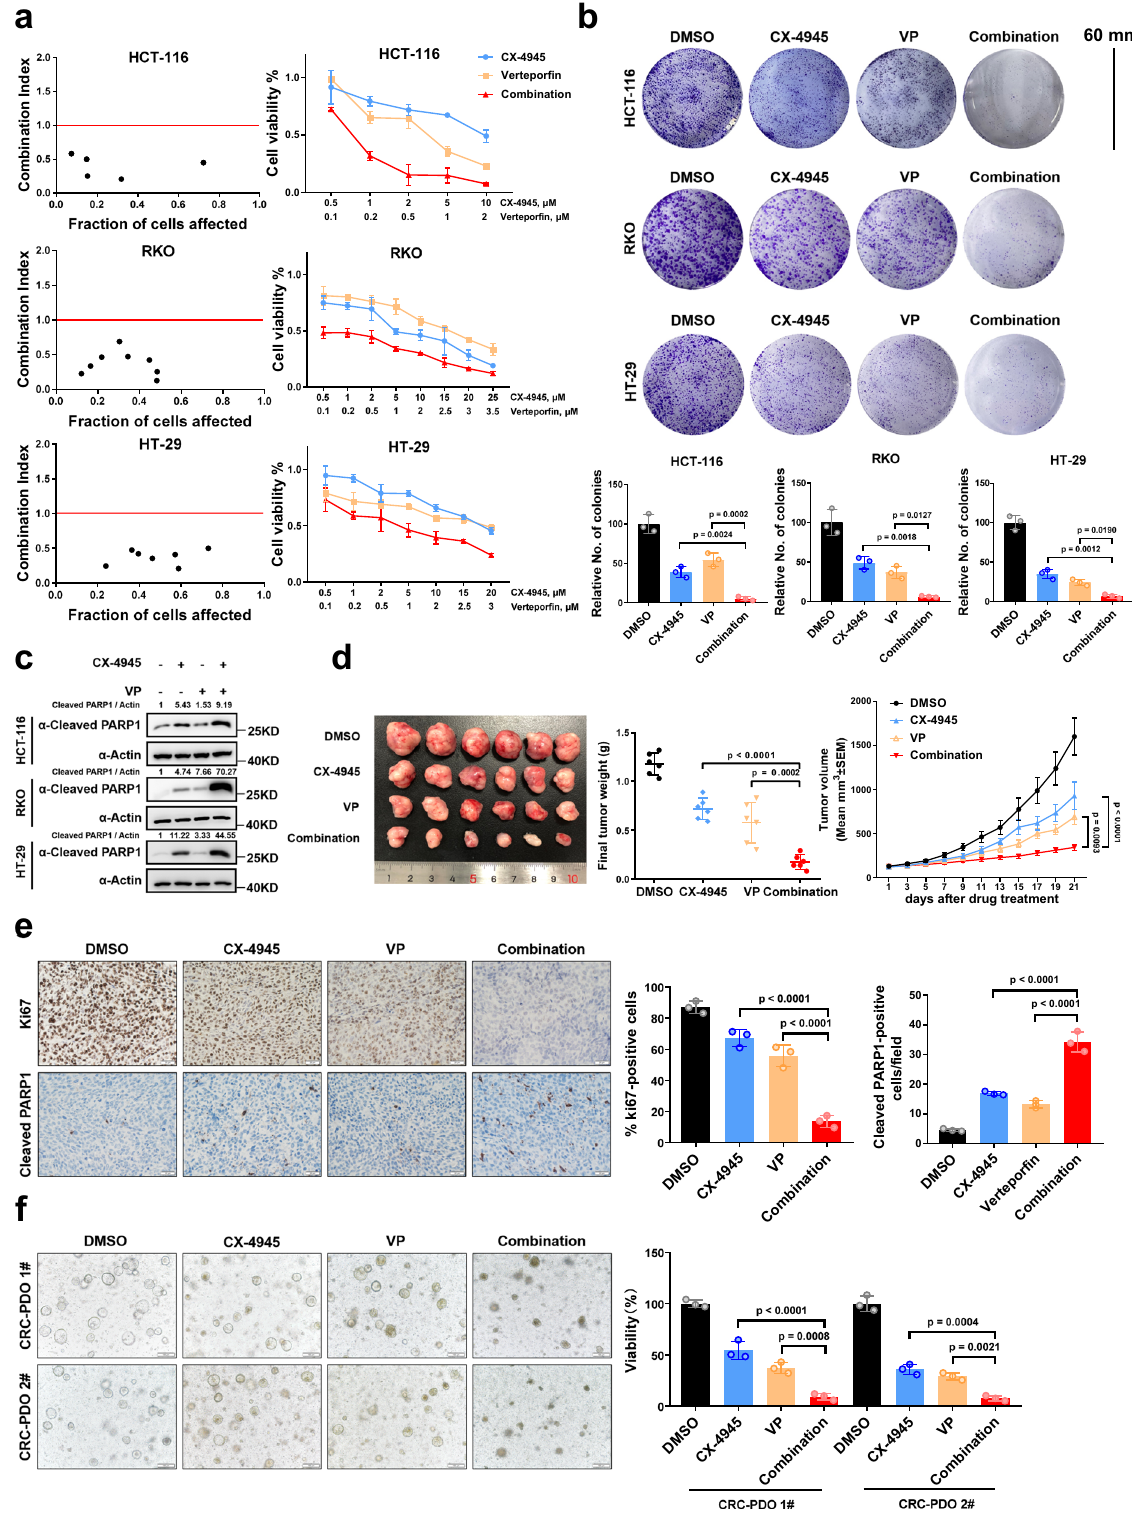
protocol by using the heat-induced epitope retrieval method. The semiquantitative analysis was performed as followed: The staining intensity was scored as 0 (lack of staining), 1 (weak staining), 2 (mod- erate staining), or 3 (strong staining), and the percentage of staining was scored as 1 (<25%), 2 (25 – 50%), 3 (50 – 75%), or 4 (>75%). IHC staining was assessed by two independent pathologists. Low and high expression of HHEX were de fi ned as IRS< 6 and ≥ 6,